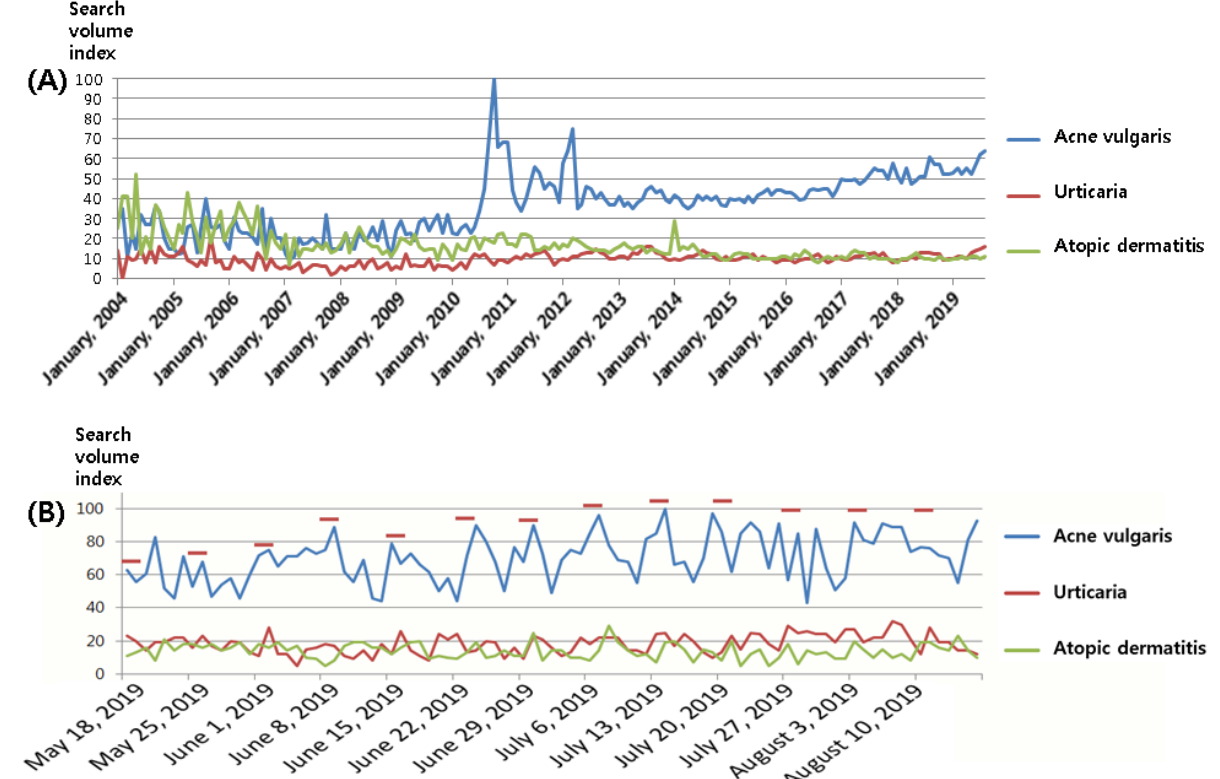
Figure 1. Temporal trends in searches for acne: (A) Google Trends time data (15 years). The search volume index (0 to 100) represents the